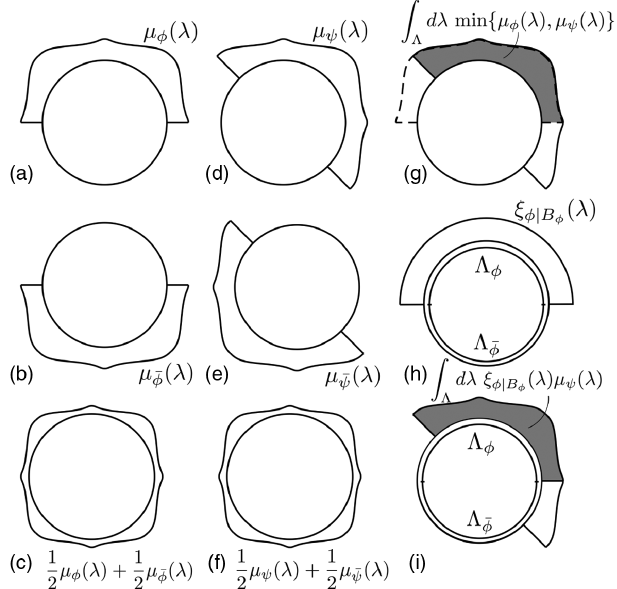
FIG. 4. In a noncontextual model of an MESD scenario: (a) – (f) epistemic states, (g) classical overlap between μ ϕ ð λ Þ and μ ψ ð λ Þ , (h) response function ξ ϕ ð λ Þ , with indication of Λ ϕ ≡ j B ϕ supp ½ μ ϕ ð λ Þ(cid:2) and Λ ¯ ϕ ≡ supp ½ μ ¯ ϕ ð λ Þ(cid:2) , (i) confusability defined by ξ λ Þ , also with indication of Λ Λ ¯ ϕ j B ϕ ð ϕ and ϕ